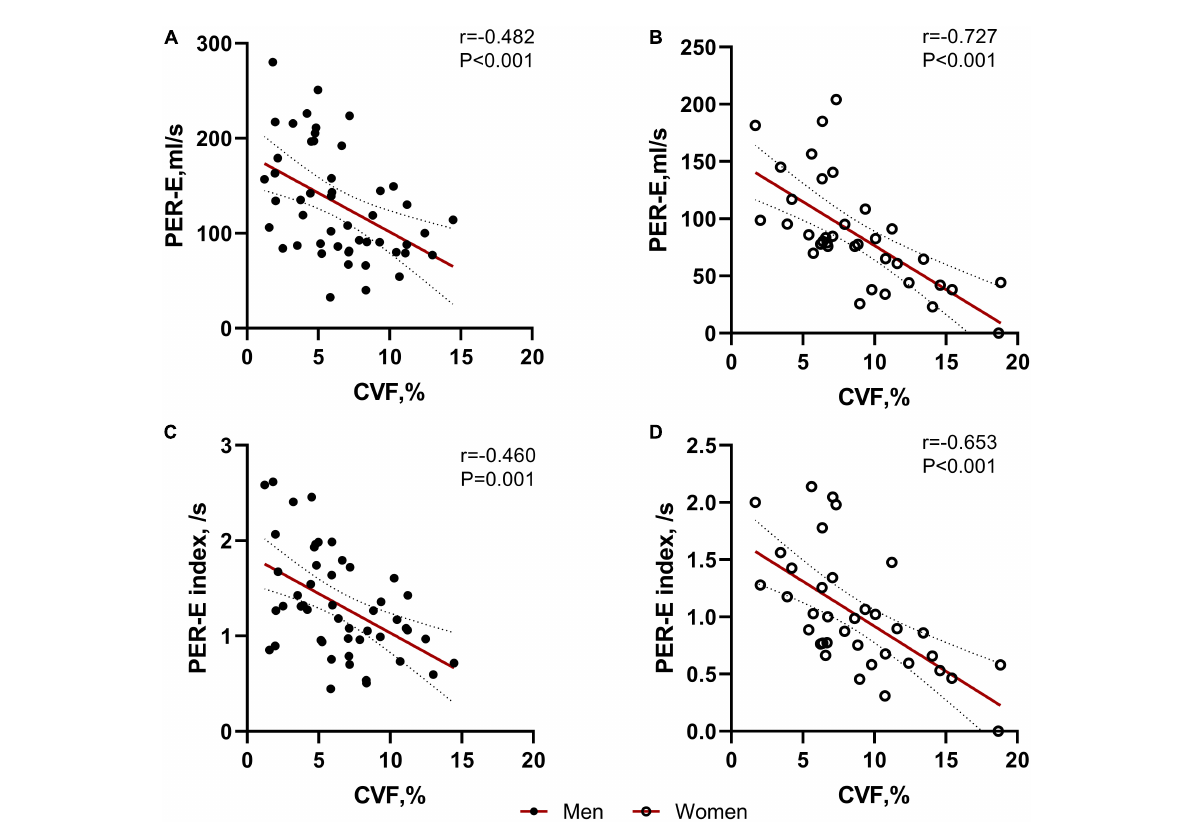
FIGURE3 Correlations between collagen volume fraction (CVF) and left atrial (LA) deformation rates in both sexes. CVF was significantly correlated with PER-E and PER-E index in males (A,C) and females (B,D) .